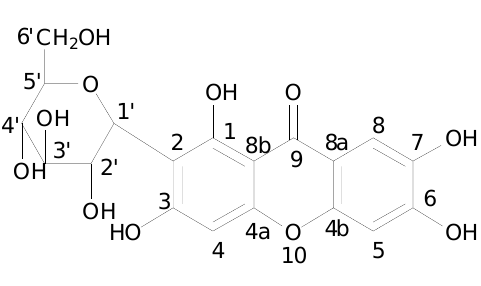
Figure 1. Structure of